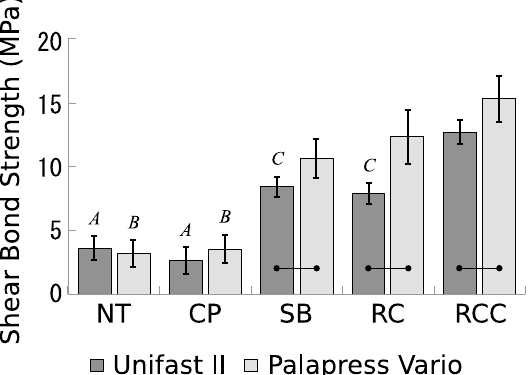
Figure 2. Means and standard deviations of shear bond strengths for surface-treated polyetheretherketone (PEEK) and bonded resins. Means with the same uppercase letters indicate no significant difference ( p > 0.05) in the treatments. Means with bars indicate a significant difference ( p < 0.05) in the two resins.